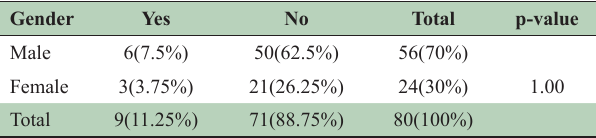
Table-III: Hypersensitivity reaction among Male and Female participants.